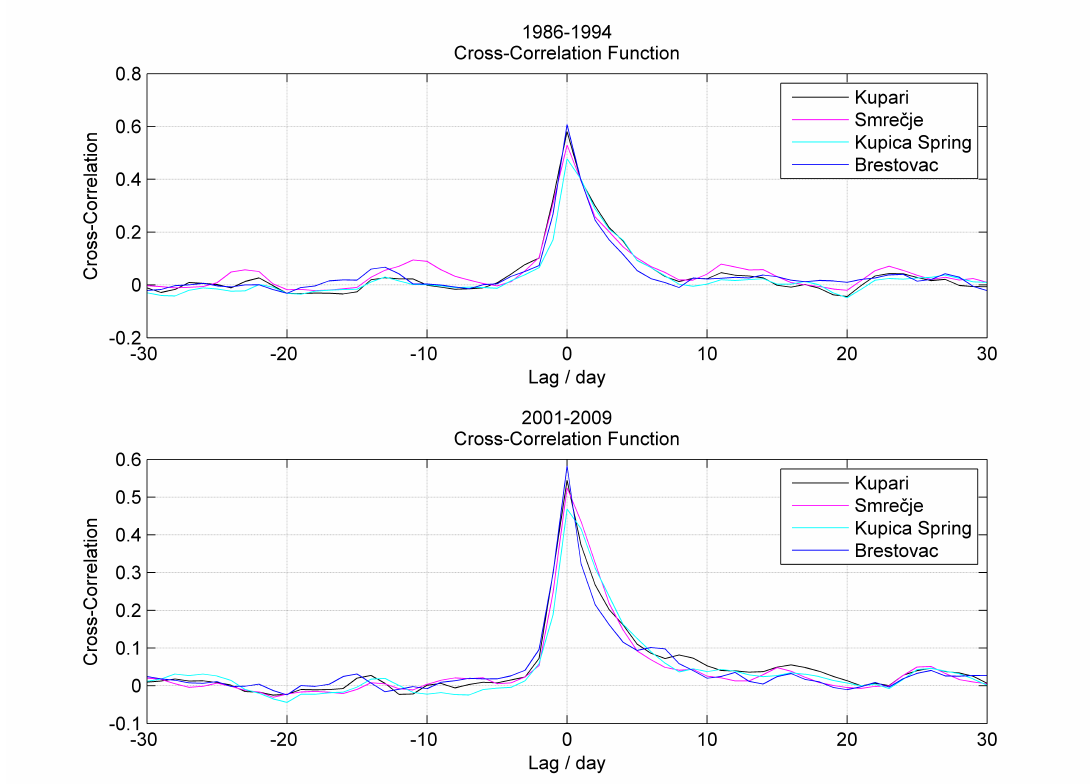
Figure 5. The cross-correlation function obtained for studied hydrological and meteorological stations for the two analyzed